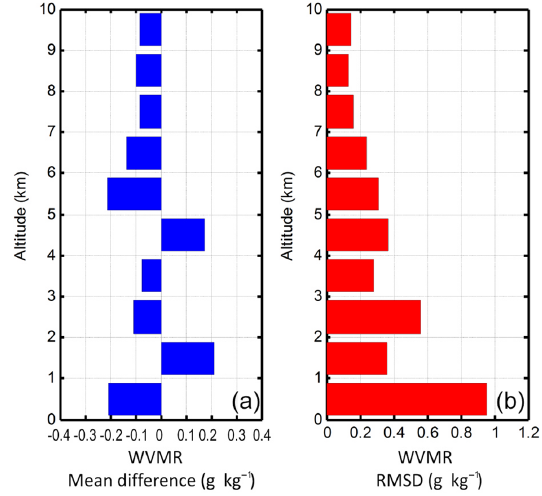
Figure 5. Average deviations between profiles of WVMR by bal- loon radiosondes and lidar shown in Fig. 4: (a) mean difference and (b) root mean square difference